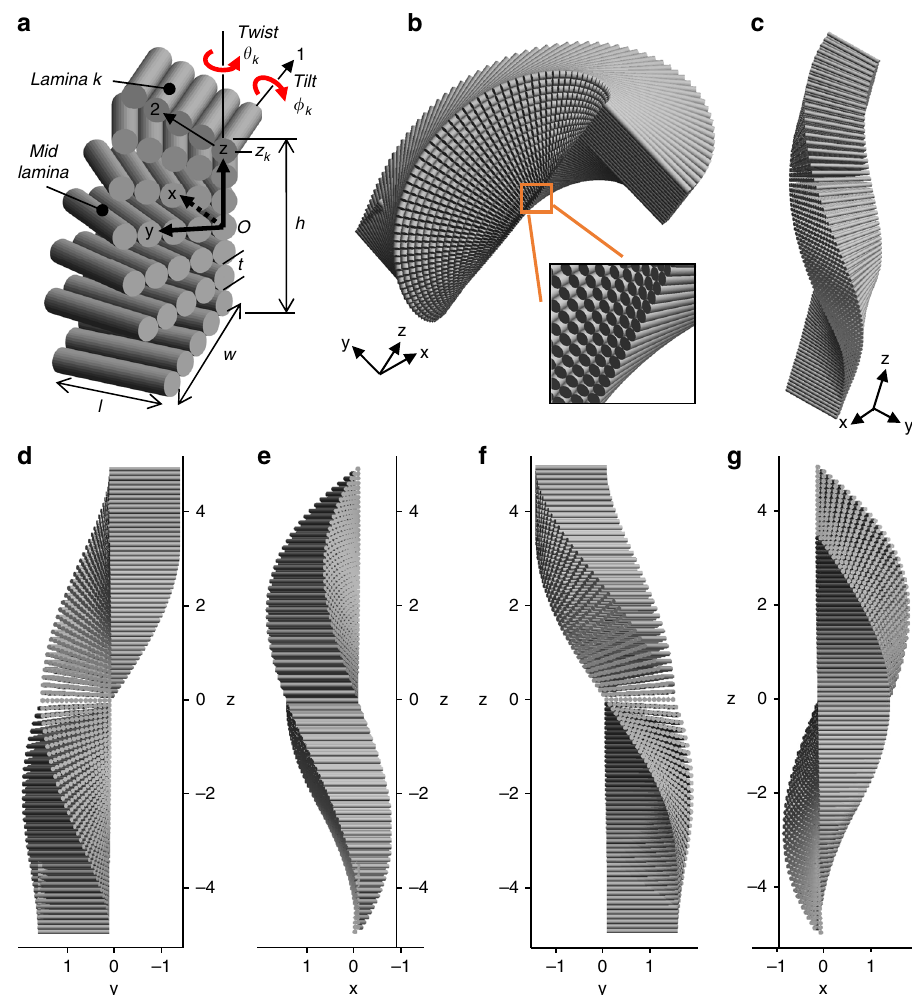
Fig. 5 BLU (Bouligand laminate unit) geometrical model. a Coordinate systems – layer/laminate ( x,y ) and lamina (1,2); lamina k twist angle is θ k , tilt angle is ϕ k , and z -position is z k ; l and w are lamina length and width. b – g Views of modeled BLU. The parameters are: number of laminae n = 71, lamina thickness t = 100 nm, lamina size l = w = 1.5 μ m, range of twist angle θ = ± 90° left turn, range of tilt angle ϕ ¼ (cid:3) 90 (cid:4) , angular increment δ θ = − δ ϕ = − 2.54°, height (excluding tilt contribution) h = 7.1 μ